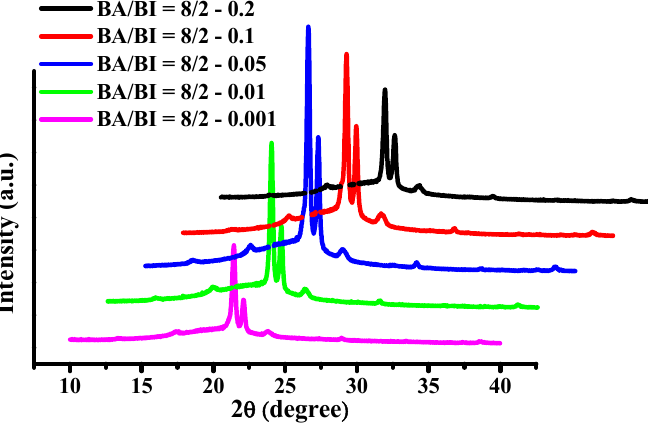
Figure 15. X-ray di ff raction (XRD) of BA / BI = 8 / 2 of the PBABI copolyesters with di ff erent concentration Figure 15. X-ray diffraction (XRD) of BA/BI = 8/2 of the PBABI copolyesters with different of EDTA. concentration of EDTA.